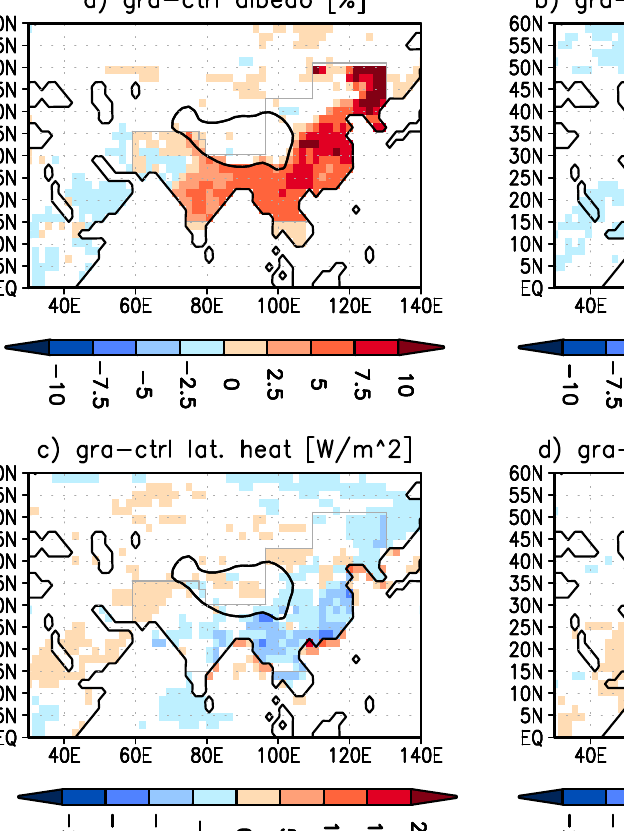
Fig. 12. Same as Fig. 11, but for the dry/cold season.